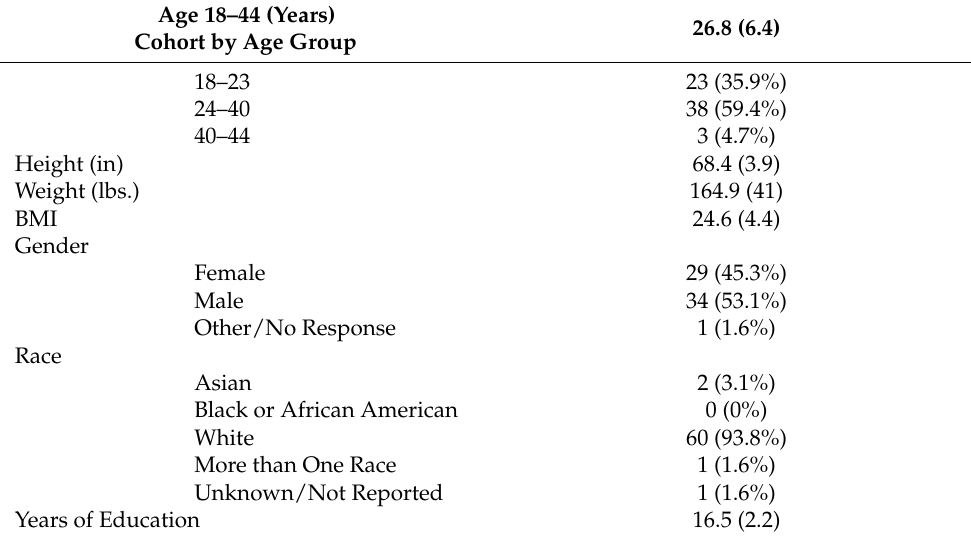
Table 1. Participant demographics ( n = 64).